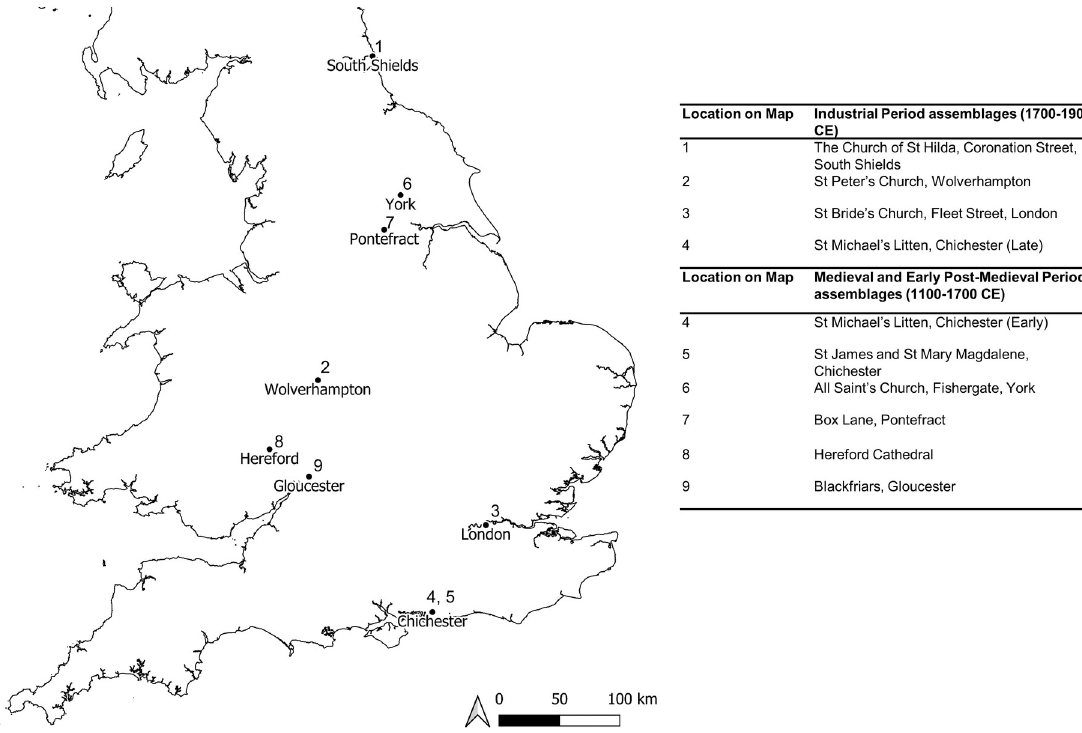
Fig 1. Map showing the location of the cemetery assemblages examined in the current research. Assemblages were excavated at towns and cities across England and represented a variety of burial contexts, including lay cemeteries, those associated with monasteries and a leper hospital. Cemeteries with an approximate date range are indicated by circa (c.). Contains OS data © Crown copyright [and database right] [2021].